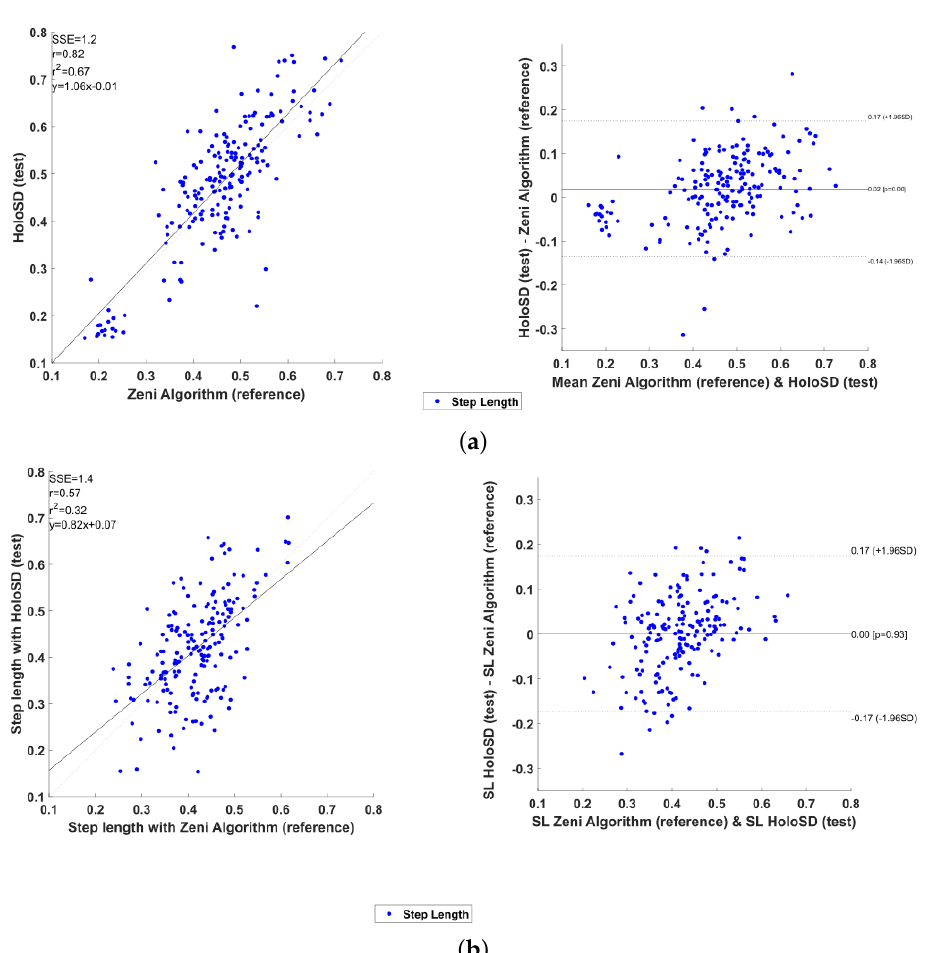
Figure 6. Statistical analysis graphics for children with CP. Left: Linear Distribution of step length between the two algorithms. Right: Bland and Altman plot representing step length. A bolt horizontal line representing the bias. Additional dotted horizontal lines, limits of agreement, are added to the plot at ¯ d ± 1.96 SD. ( a ) Children with CP—Group 1 ( b ) Children with CP—Group